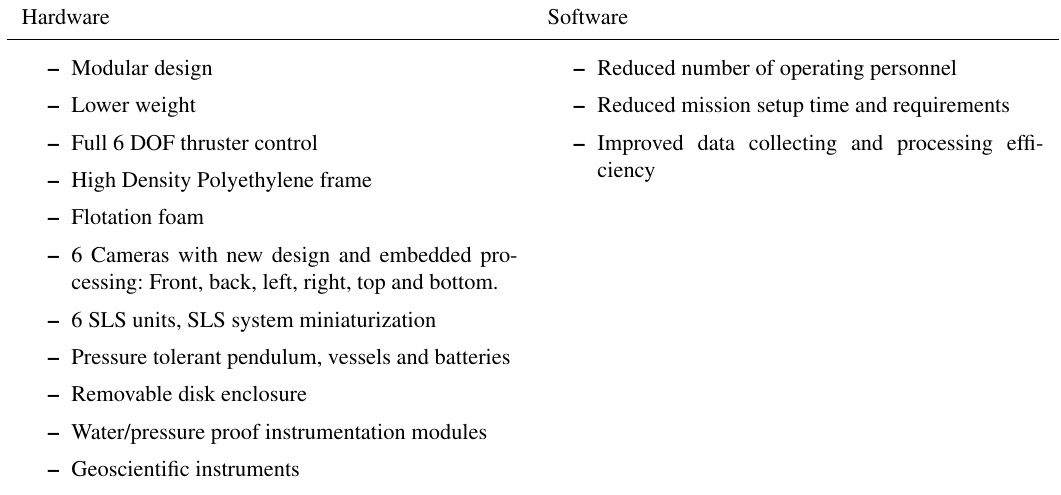
Table 3. Hardware and software improvements of UX-1